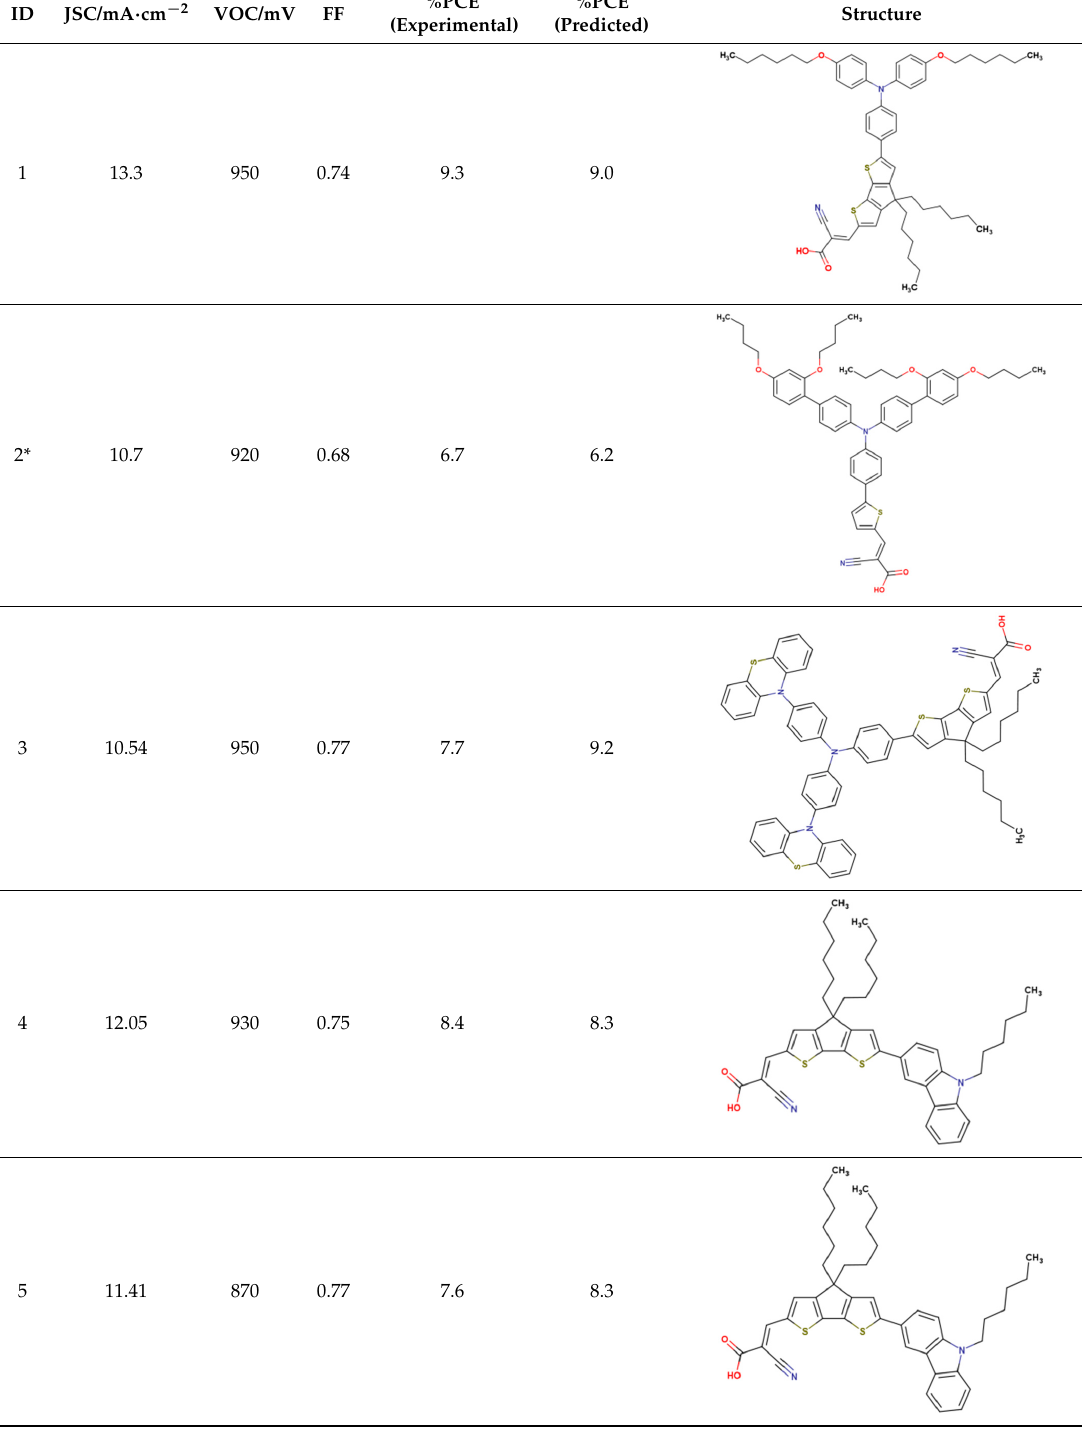
Table 1. Chemical structure of arylamine organic dyes tested in DSSCs employing liquid cobalt electrolytes with their experimental and predicted %PCE values.